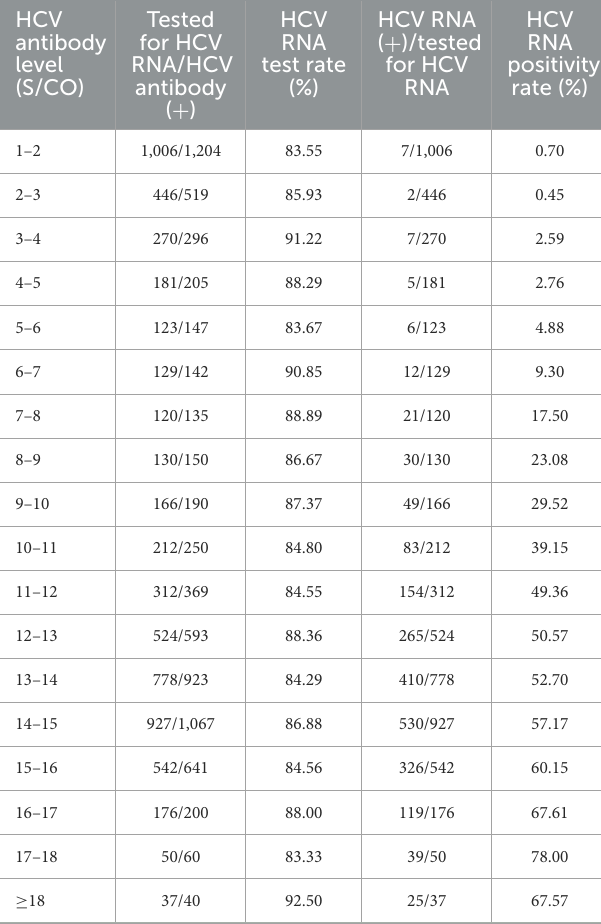
TABLE 2 Correlation between HCV antibody level and HCV RNA. HCV